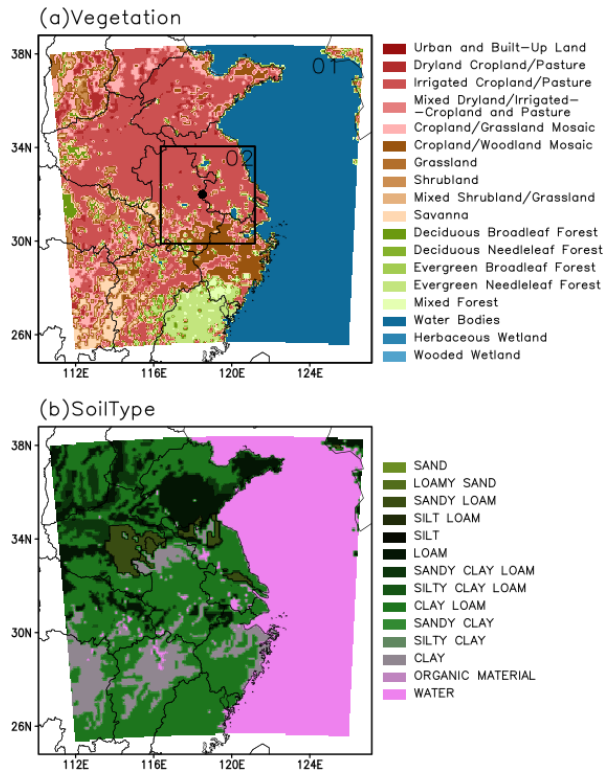
Figure 1. ( a ) Map of model domains (thick solid box), surface vegetation (shaded) and model domains centered at Nanjing (thick black solid circle, at 32.0°N, 118.5°E); and ( b ) soil type (shaded).